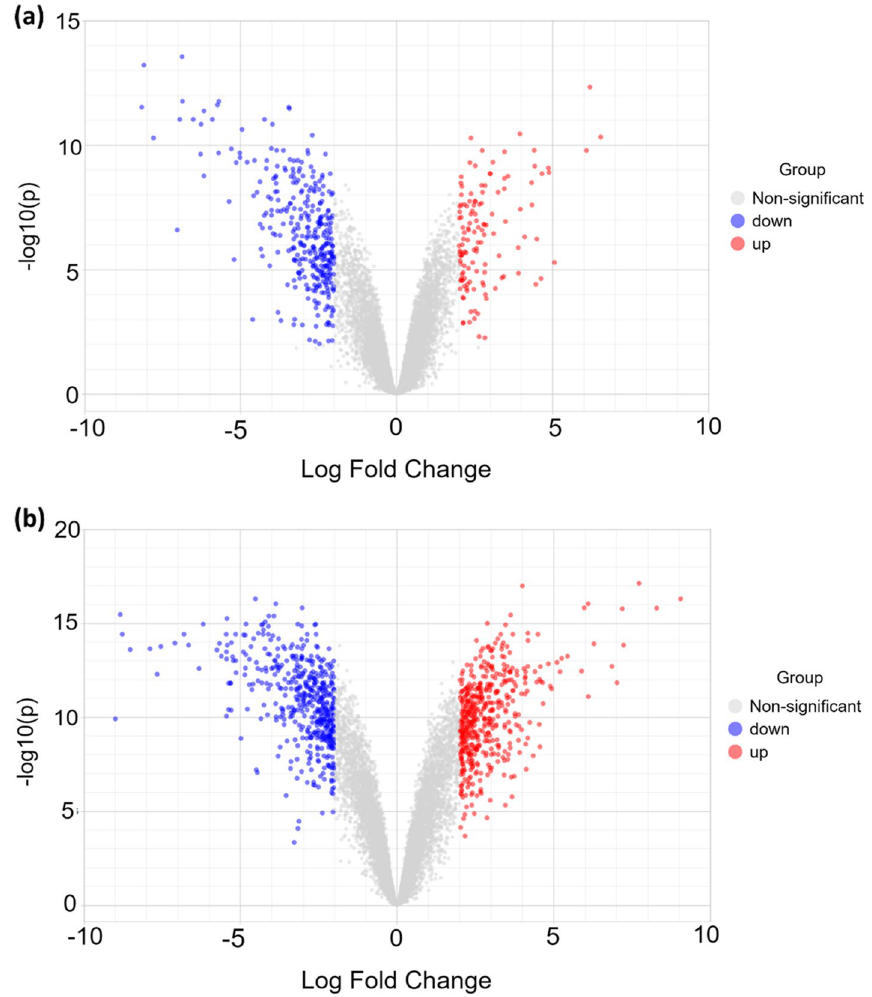
Fig. 3 Volcano plots: Volcano plots of all genes in the data sets, with each dot representing an individual gene. Blue dots show the genes which are downregulated, red dots show the genes which are upregulated, and the grey dots are genes which are non-significant. The X-axis is the log2-base fold change, and the Y-axis is the -log10-base adjusted P -value. a the human data set, GSE17579. b mouse data set,